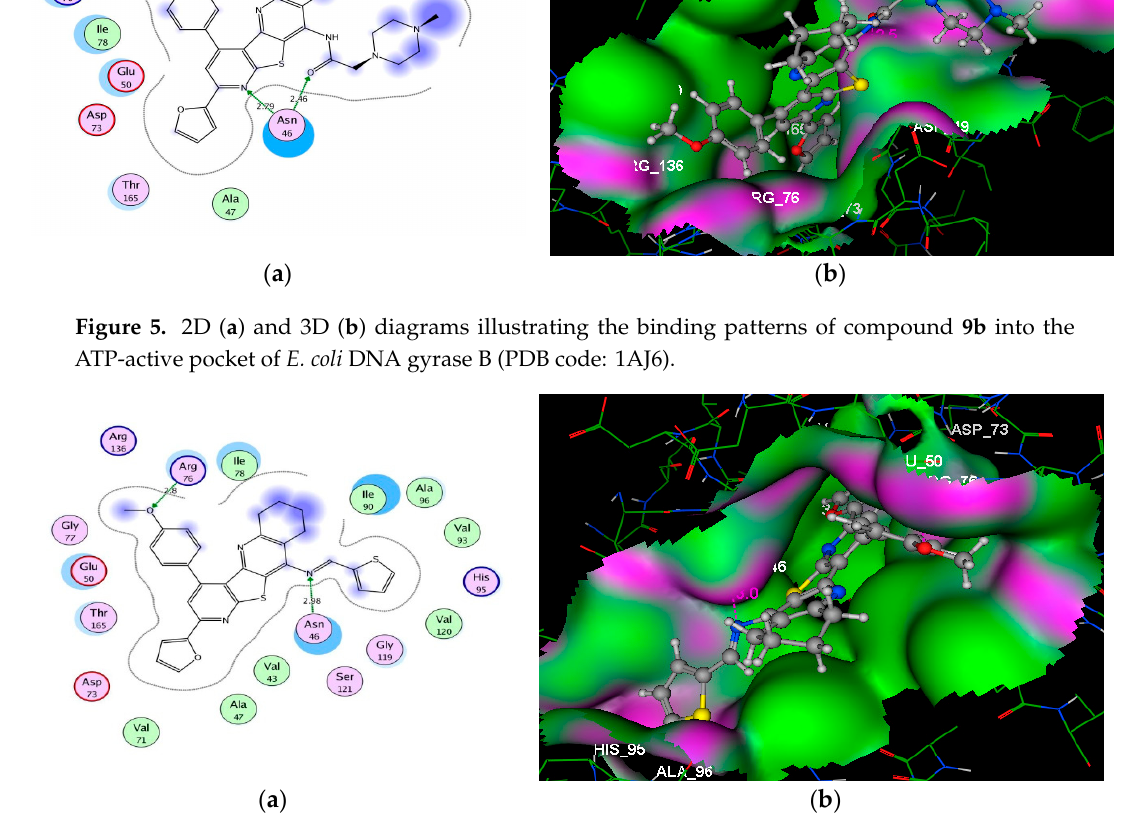
Figure 6. 2D ( a ) and 3D ( b ) diagrams illustrating the binding patterns of compound 12b into the ATP-active pocket of E. coli DNA gyrase B (PDB code: 1AJ6).